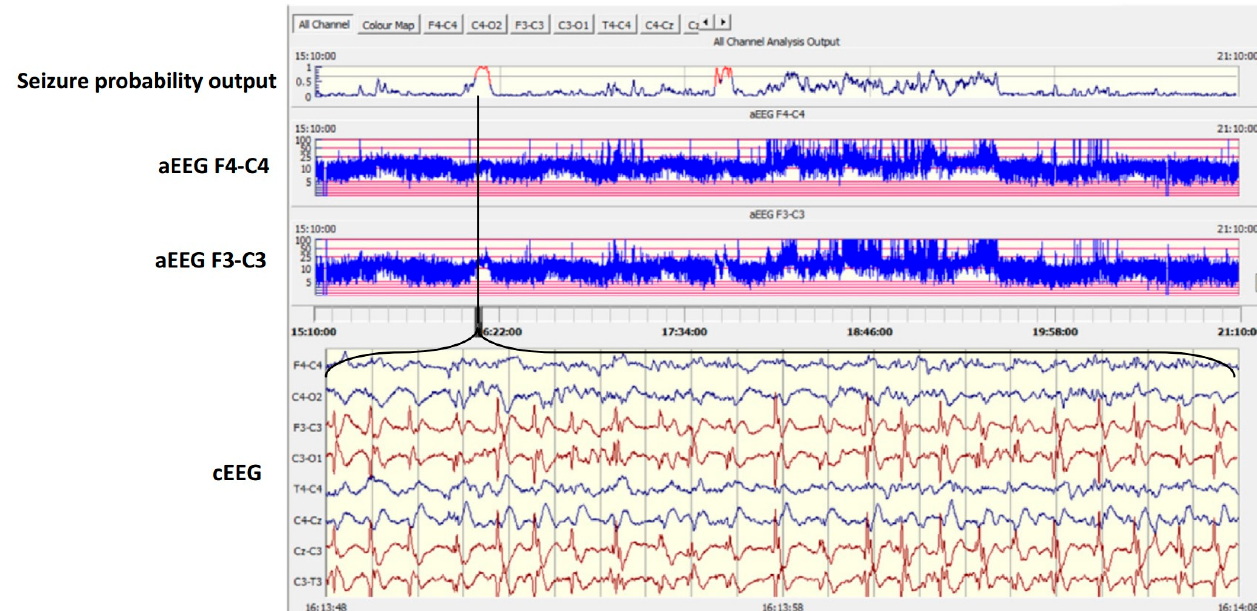
Figure 1. An EEG viewer incorporating an SDA. In the upper panel the output of the SDA is displayed as a graph of seizure probability. The trace changes to red and an annotation is made when a seizure is identified. The interface also displays the cEEG and aEEG (source: [39]).